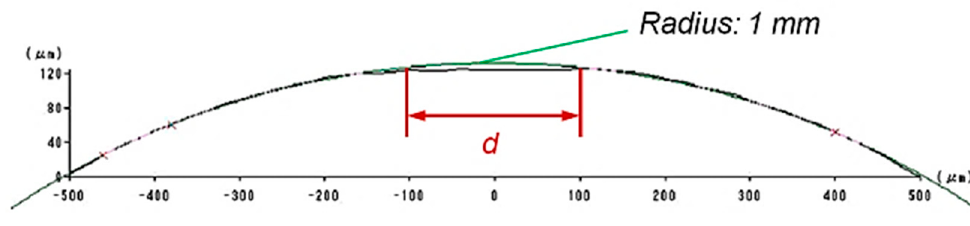
Figure 13. Wear diameter d .